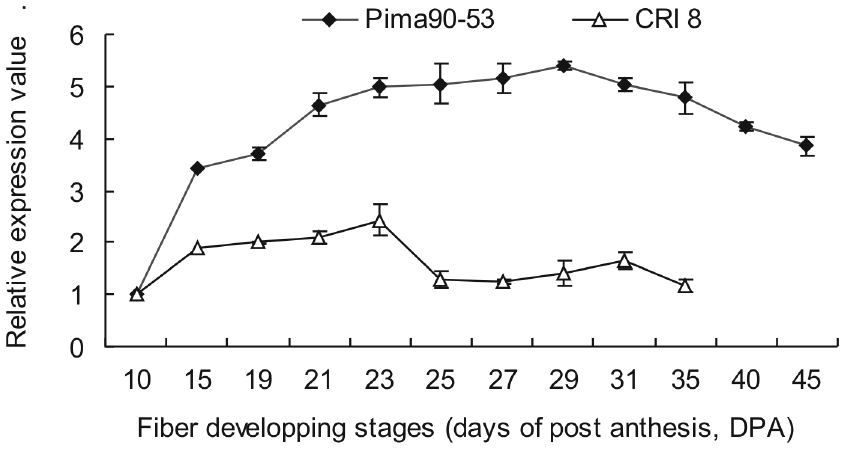
Figure 7. Relative expression analysis of FLA5 mRNAs in developing fibers by real-time quantitative PCR. EF1α was used as the internal control. Cotton fiber development stages (DPA) are as showed under the